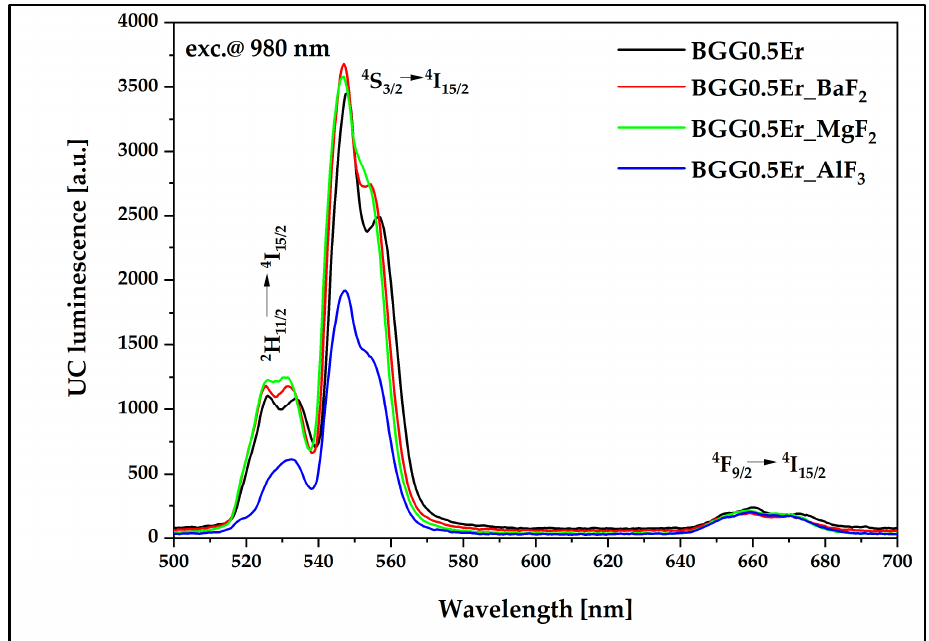
Figure 17. UC luminescence of Er 3+ -doped BGG glass modified by different fluoride compounds under 980 nm laser excitation.